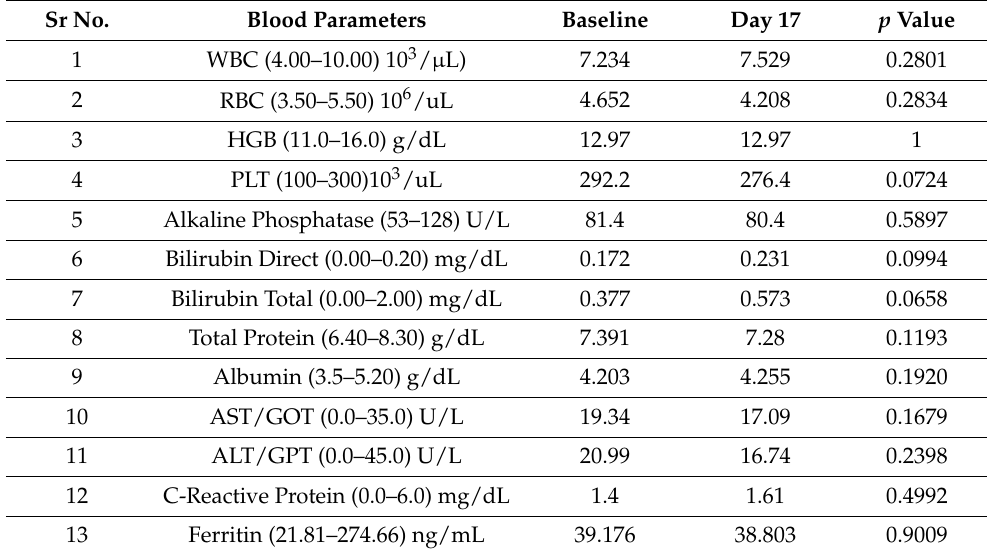
Table 2. Basic laboratory parameters during the study course ( t -Test, Paired two Sample for Means). Sr No. Blood